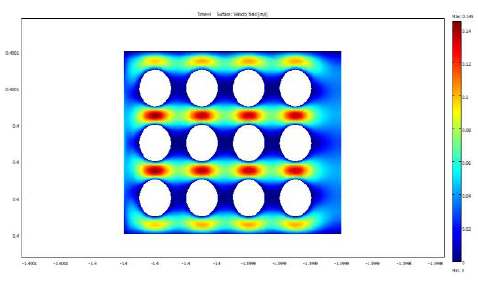
Figure 1. An example of the velocity field solved with a finite element analysis model in COMSOL Multiphysics. The 2D array consists of 10 micron pillars and 10 micron gaps. A difference in pressure is applied from left to right of the array and velocity is measured at each element. The velocity profile shows that the pillars create regions of slow and fast fluid movement, being blue and red respectively. As it can be seen the highest velocity is achieved between the